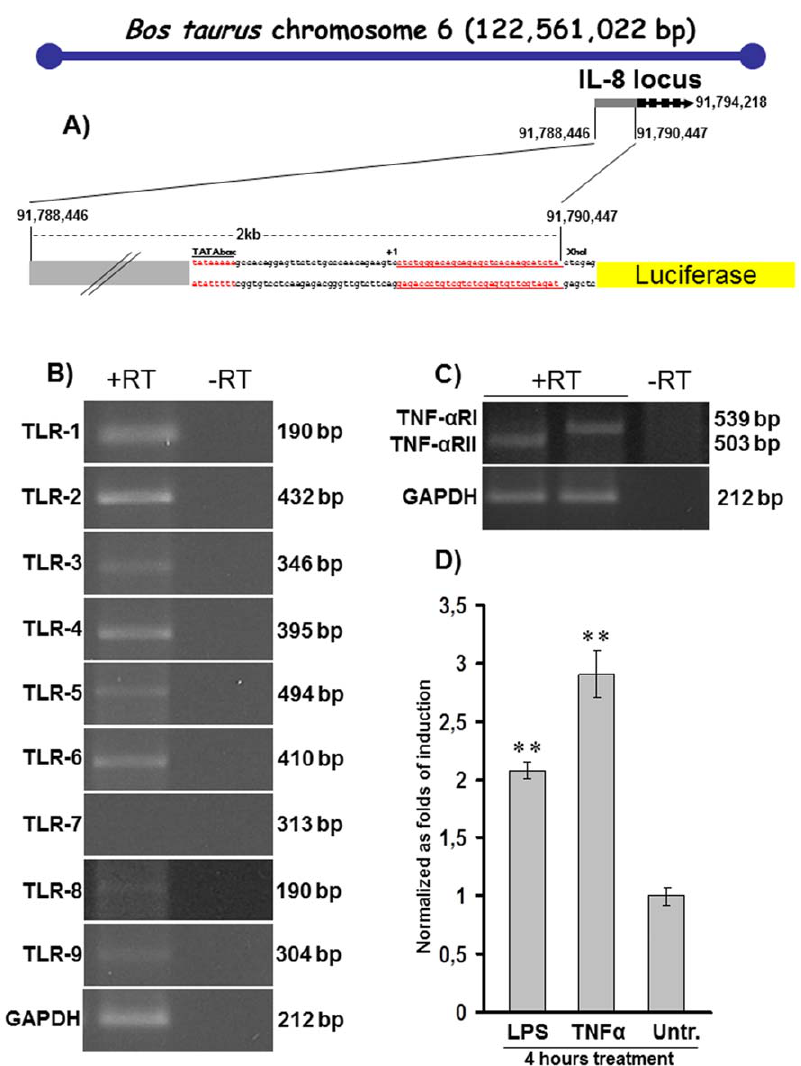
Figure 1. Invitro characterization of bIL-8-Luc reporter construct. A ) Schematic diagram (not to scale) of the Bos taurus chromosome 6 with the IL-8 gene locus comprising promoter and exons annotated by numbers. The 2 kb IL-8 promoter sequence, comprising the putative TATA box, the transcriptional start site ( + 1) and the UTR (red underlined) was cloned into the pGL3 basic vector in front of the open reading frame of the Luciferase reporter. B ) RT-PCR products of TLRs from 1 to 9 and their corresponding amplicon size. GAPDH was used as an internal control and the amplification performed in the absence of reverse transcriptase (-RT) as a negative control. C ) RT-PCR products of TNF- a RI,II and their corresponding amplicon size. GAPDH was used as an internal control and the amplification performed in the absence of reverse transcriptase (-RT) as a negative control. D) IL-8 promoter activation after treatment of bIL-8-Luc transfected LA-4 cells with LPS or TNF- a , along with the untreated control (Untr.). Each experiment was done in quadruplicate, and each point represents the mean 6 standard deviation of three experiments. Data were expressed as folds of induction (2,1 and 2,8 for LPS and TNF- a respectively) over vehicle-treated cells and statistical differences were tested by One Way ANOVA followed by Dunnet’s post hoc test for group comparisons. Results are reported as mean 6 SD and significance attributed when P , 0.05 (*) or P ,